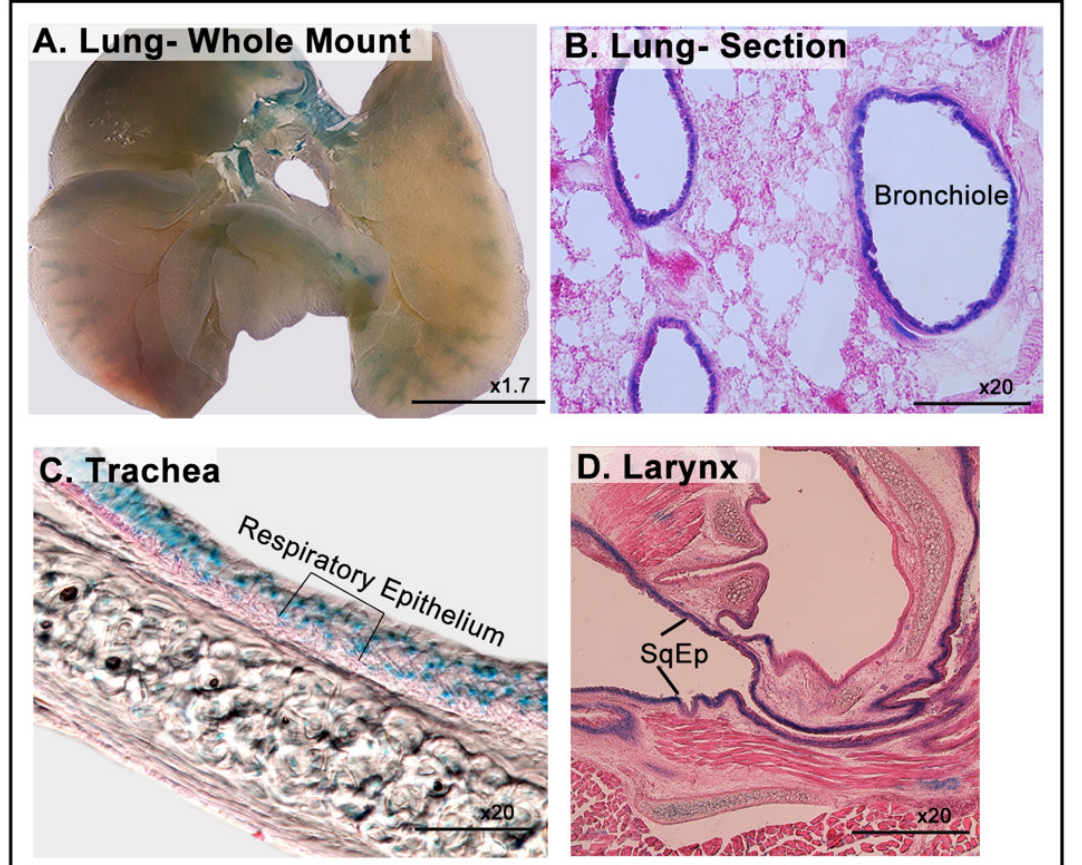
Figure 6. LacZ expression in the respiratory system. ( A ) Whole-mount staining of the lung. ( B ) Coronal section of the lung, showing an X-gal signal in the epithelial lining of the bronchioles. ( C ) X-gal signals in the respiratory epithelium lining of the trachea and squamous epithelium of the larynx ( D ).